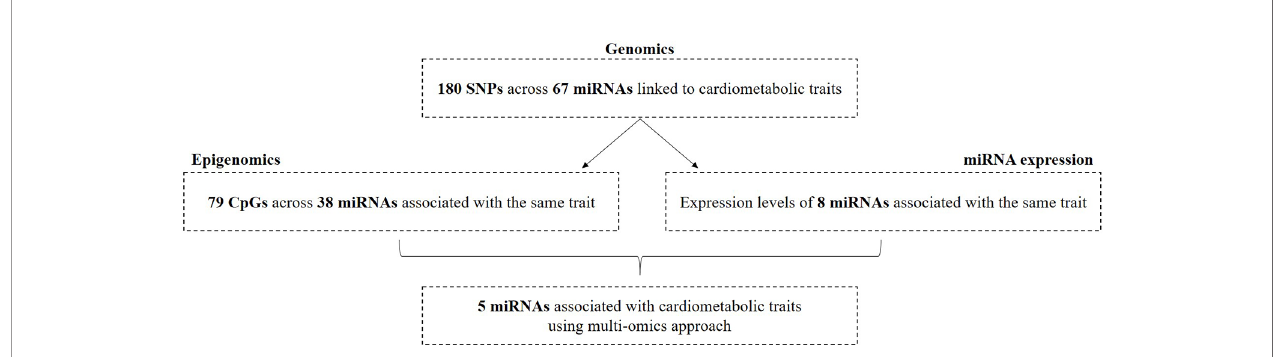
FIGURE 4 | Overview of miRNAs associated with cardiometabolic traits by integrating three